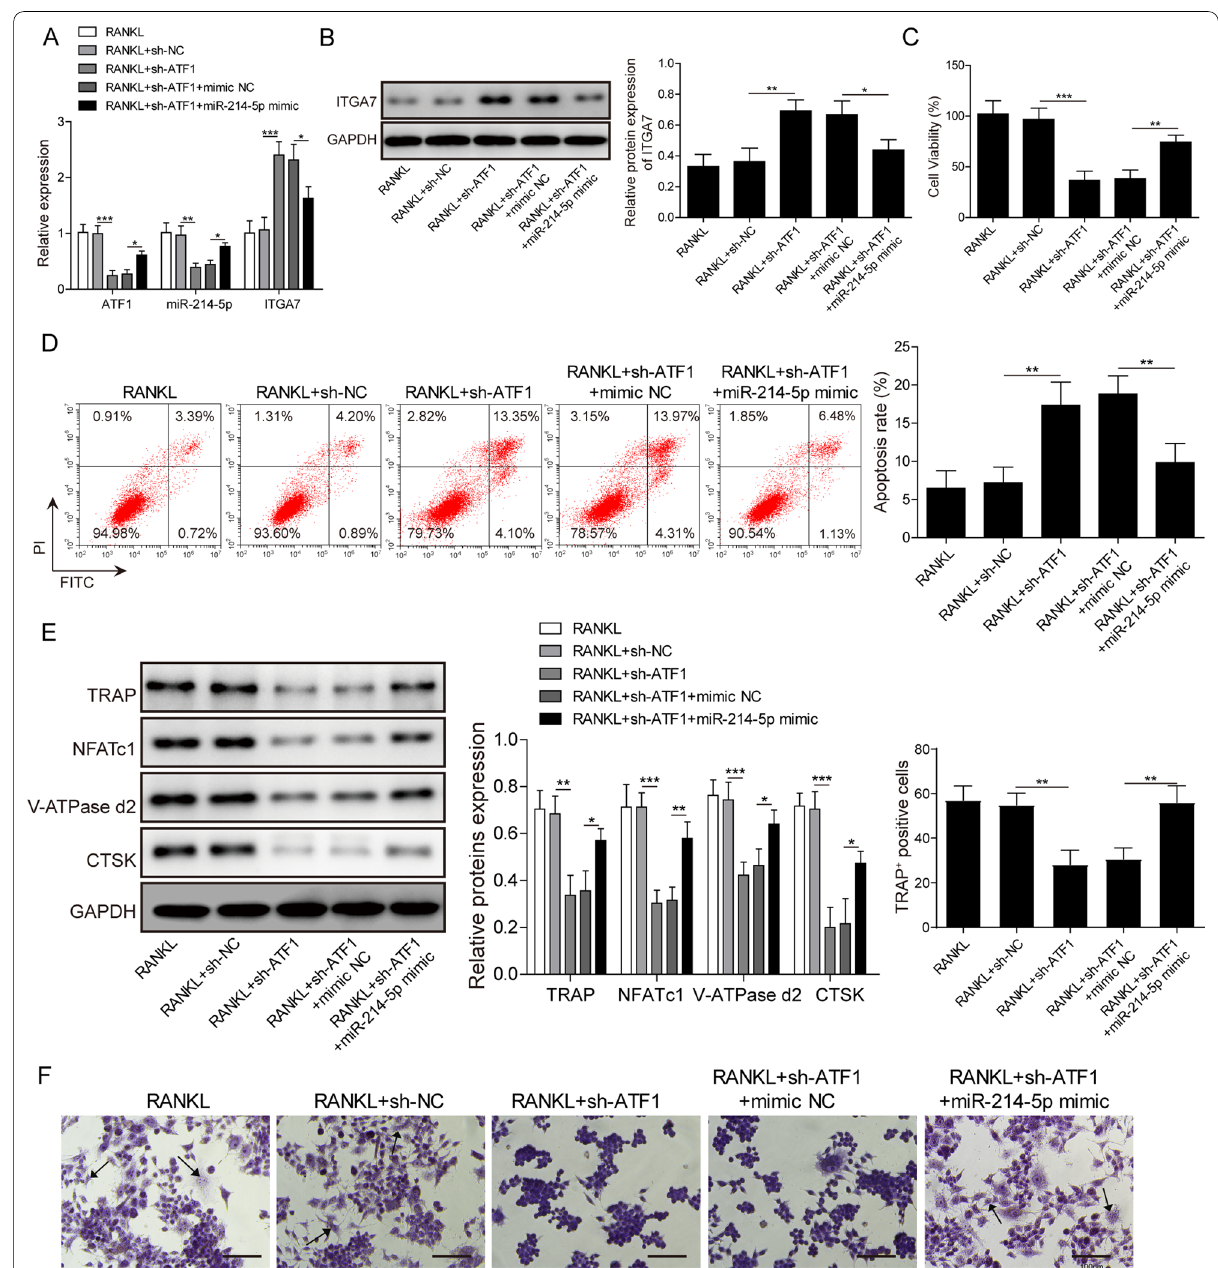
Fig. 3 ATF1 inhibition abolishes osteoclast formation, which is reversed by miR‑214‑5p upregulation. RAW264.7 cells were administrated with sh ATF1/sh NC with or without miR‑214‑5p mimic/mimic NC. A Expression of ATF1, miR‑214‑5p and ITGA7 was detected by qRT‑PCR. B Protein level of ITGA7 was detected by western blotting. C Cell viability was evaluated by CCK‑8 assay. D Cell apoptosis was assessed by flow cytometry. E Expression of osteoclast markers was evaluated by western blotting. F TRAP staining results in each group. Experiments were performed for at least 3 times. Data are presented as mean SD. *P < 0.05, **P < 0.01 and ***P < ±